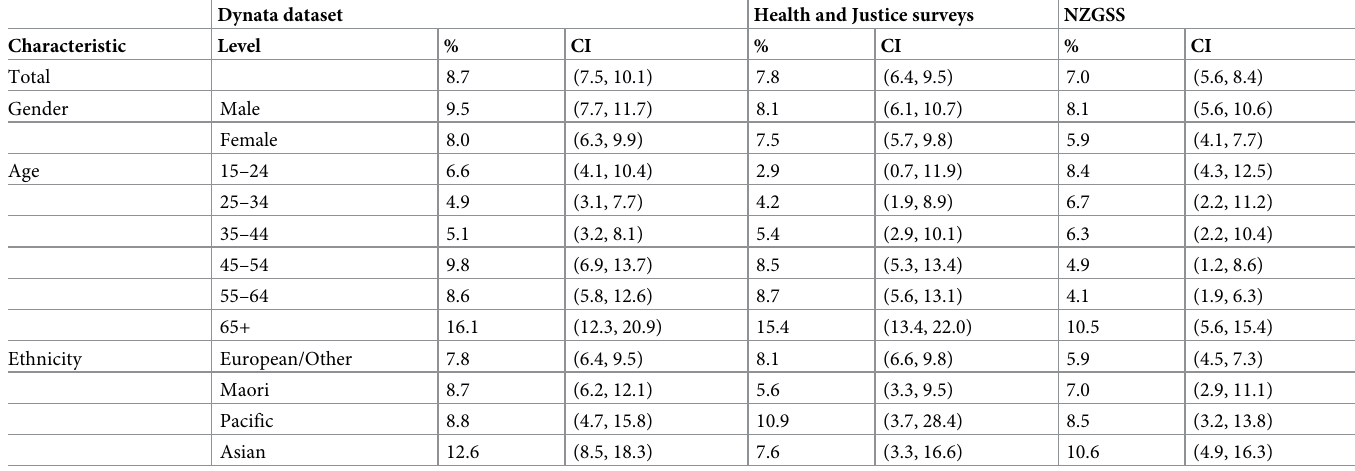
Table 2. Excellent wellbeing status: Comparison with WHO-5 data from the 2018